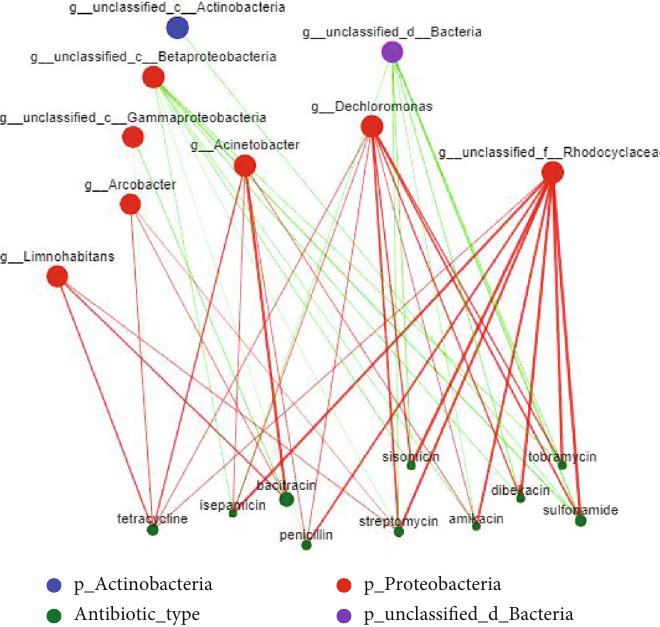
Figure 7: Correlation between microbes and ARGs based on antibiotic